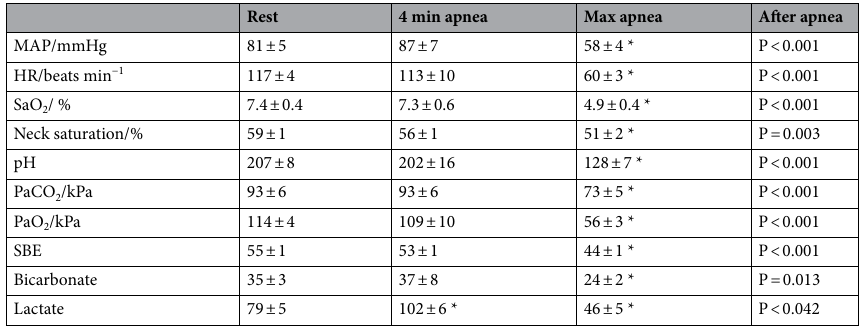
Parameter Rest End of apnea with max expiration End of apnea with GPI P-value: GPI compared to rest LV EDV, ml